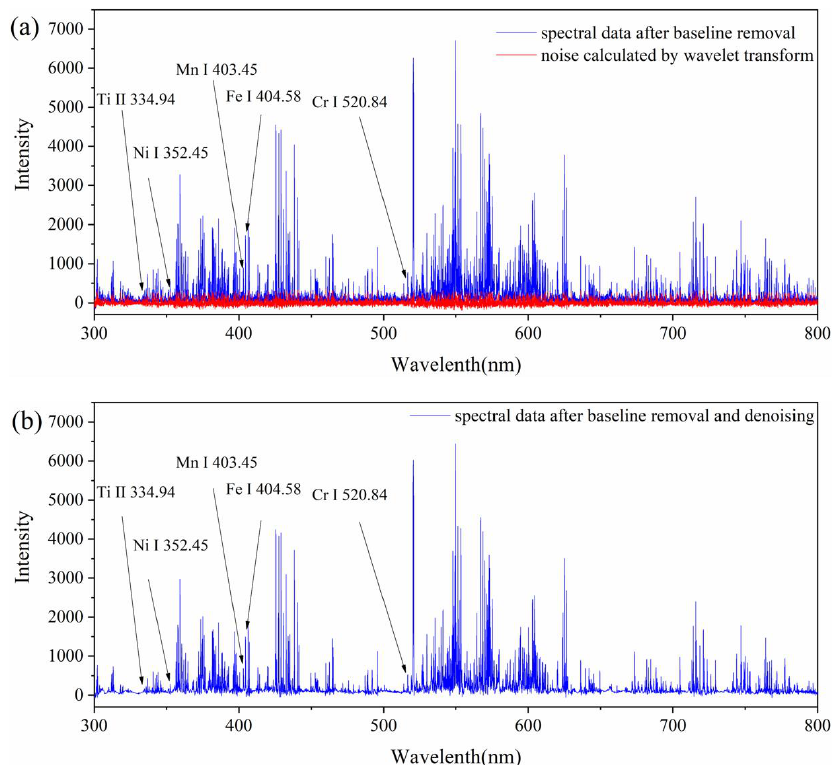
Figure 4. LIBS spectrum of sample GBW 01659a in the wavelength range of 300 – 800 nm: ( a ) the spectral data after baseline removal (blue line, same as Figure 3b) and noise data calculated by wavelet transform (red line); ( b ) the data after denoising, obtained via subtracting the noise data from the data after baseline removal.